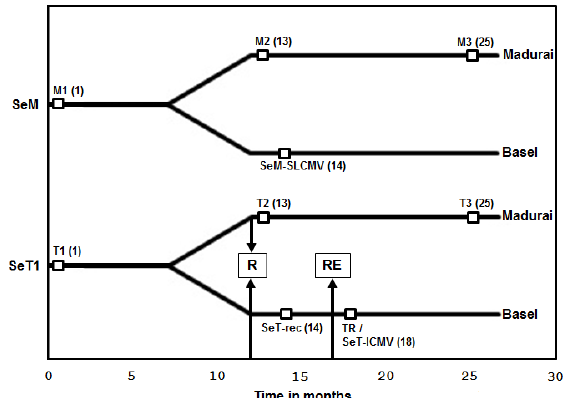
Figure 1. Timelines of cassava plant establishment in Madurai and Basel greenhouses and periods at which samples were taken for DNA and RNA extraction. The periods (in months) following the initial establishment of cassava plants ( Manihot esculenta Crantz) in Madurai are represented in the x -axis. SeM, the cassava plant collected from Malappuram; SeT1, the cassava plant collected from Thiruvananthapuram. The time point 0 indicates the time of initial establishment of field-infected cassava plants in the Madurai greenhouse. The plants were established in the Basel greenhouse eight months after initial establishment in Madurai. R denotes the time of recovery of the SeT 1 plant from cassava mosaic disease (CMD) and RE denotes the time of re-emergence of CMD symptoms. M1, M2 and M3 are the time points at which DNA was extracted from SeM plants. T1, T2 and T3 are the time points at which DNA was extracted from SeT1 plants (both maintained in the Madurai greenhouse). Time points of RNA extraction in SeM plants (SeM-SLCMV), SeT1 plants at the recovery stage (SeT-rec) and SeT plants at the re-emergent stage (SeT-ICMV) are marked. The number of months from the initial establishment of cassava plants in Madurai is given in